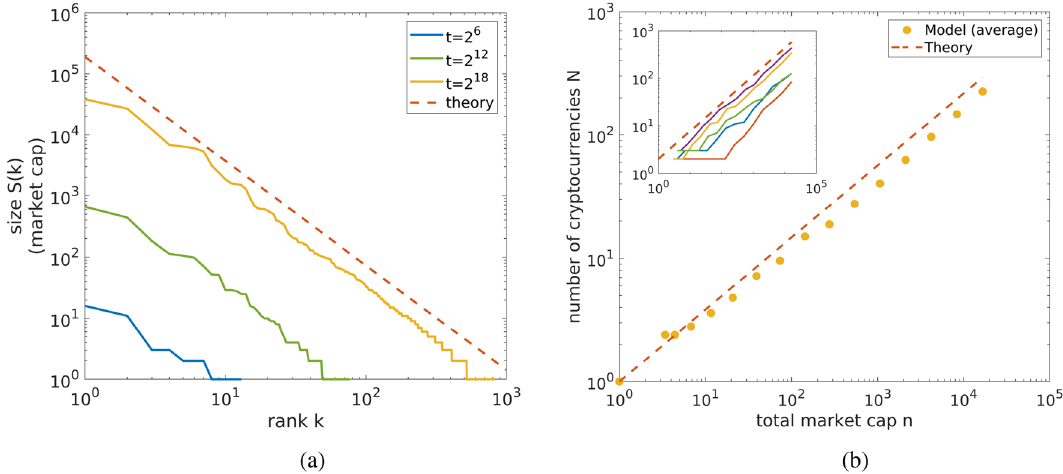
Figure 5. ( a ) Rank-size plots. Rank-size plots obtained from our model with (cid:31) N = 1.58 . The model produces a Zipf’s law with exponent given by 1 /(� N − 1 ) ; the red dashed line is the theoretical prediction. ( b ) Heaps’ law. Growth of the number of coins in the model as function of the market cap. Yellow points have been obtained averaging over 5 different realizations (shown in the inset), while the red dashed lines is the theoretical Heaps’ law with exponent (cid:31) N − 1 . Figures created with Matlab R2021a https:// it. mathw orks. com/ produ cts/ matlab.